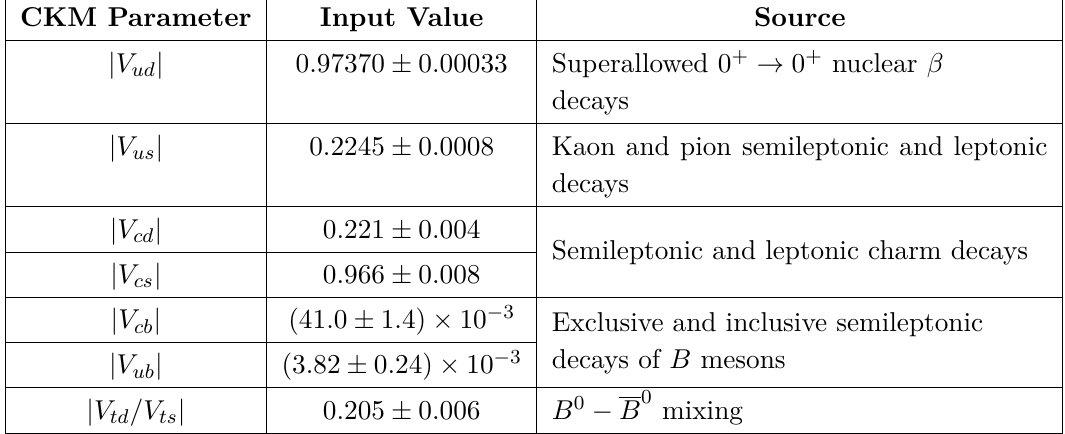
Table 4 . Inputs [75, 76] used for the CKM fit and processes from which they are obtained. The error of | V ud | has been increased by a factor